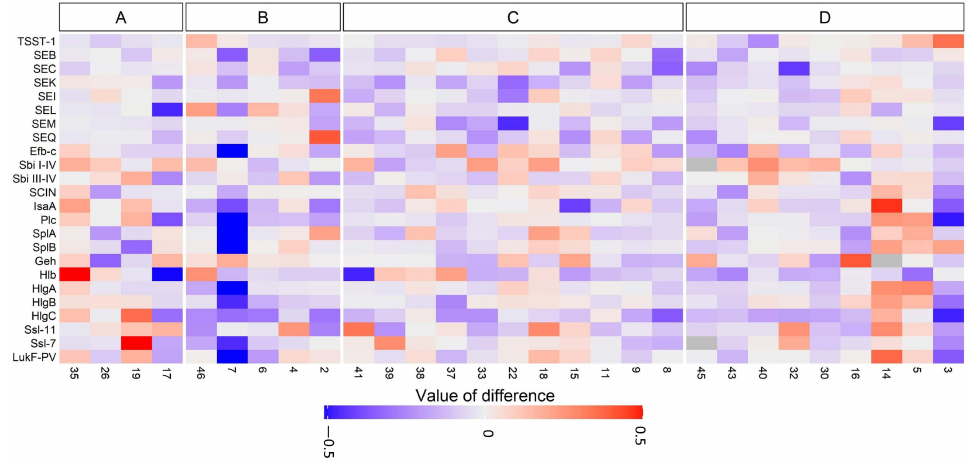
Figure 3. Heat map presenting changes in IgG responses toward staphylococcal antigens in serum from 29 CRS patients at initial collection (C1) and after 8–15 years (C2; mean follow-up: 11 years). Serum samples were available from 29/34 (85%) CRS patients at both time points. ( A ) Patients with S. aureus only at C2, ( B ) patients with S. aureus only at C1, ( C ) patients with S. aureus at both C1 and C2, and ( D ) patients with no S. aureus at either C1 or C2. Patient ID is indicated on the